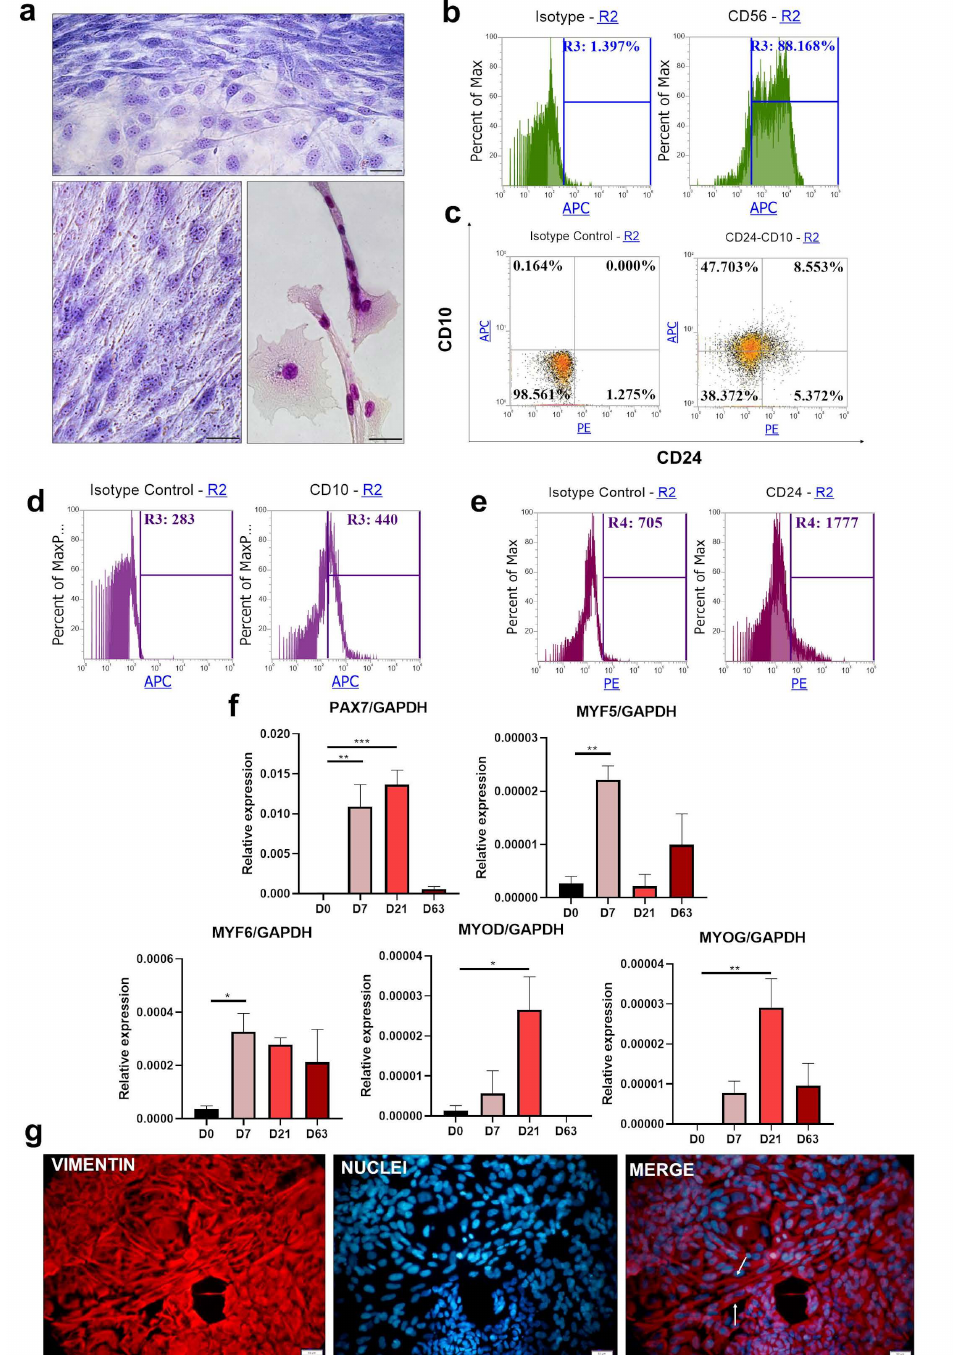
Figure 2. Differentiation of iPS cells into skeletal muscle cells with Protocol I: ( a ) morphology of the cells visualized with Wright’s staining on day 63 of the experiment. Scale bar represents 50 µ m. ( b ) representative results of flow cytometry analysis of CD56 expression on day 63; ( c ) double staining for CD10 and CD24 expression analyzed with flow cytometry on day 63, representative result; ( d ) analysis of the total CD10 + mean fluorescence intensity on day 63, representative result; ( e ) analysis of the total CD24 + mean fluorescence intensity on day 63, representative result; ( f ) qPCR analysis of myogenic genes expression during the differentiation, n = 2, * p < 0.05, ** p < 0.01; *** p < 0.001 ( g ) vimentin and cell nucleus immunofluorescence staining at the end of the experiment. Scale bar represents 50 µ m; white arrows indicate cell